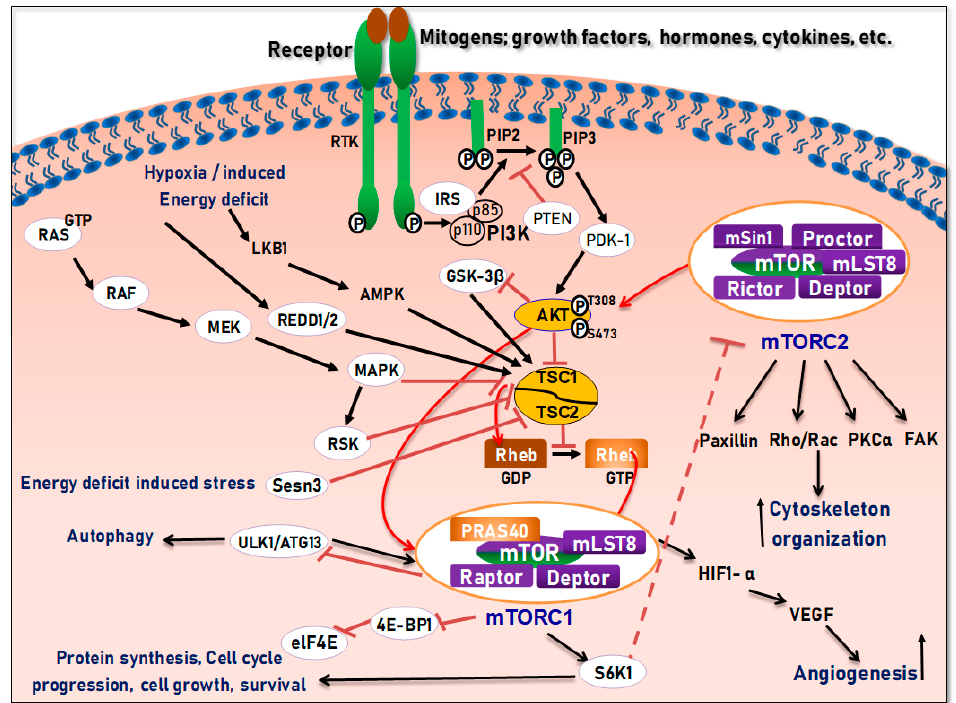
Figure 4. Schematic illustration of the PI3K / Akt / mTOR signaling pathway. Arrows represent activation, whereas bars represent inhibition [50]. Upon receptor activation, insulin receptor substrate (IRS) activates phosphatidylinositol 3-kinase (PI3K), which is in turn phosphorylated to generate phosphatidylinositol [3,4,5]-trisphosphate (PIP3). Phosphatase and tensin homolog (PTEN) can dephosphorylate PIP3 to regulate the pathway activity. AKT is activated through the binding of PIP3 to its amino terminal, pleckstrin homology (PH) domain (stripped), which then promotes the translocation of AKT to the plasma membrane, where the carboxyl terminal T308 is phosphorylated by phosphoinositide-dependent kinase-1 (PDK1), and S473 is phosphorylated by mTORC2. AKT regulates several cellular processes such as survival and cell proliferation, through a variety of downstream proteins like glycogen synthase kinase 3-beta (GSK-3 β ), Forkhead Box O (FOXO), amid others (not shown). AKT is able to directly phosphorylate and thus inactivates the 40 kDa proline-rich